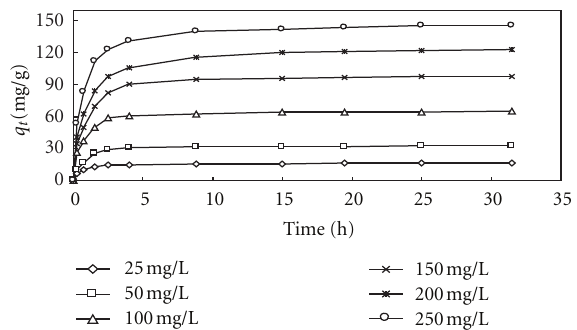
F 3: Effect of carbofuran initial concentration and agitation time on carbofuran adsorption capacity. T 1: Langmuir, Freundlich, and Temkin isotherm